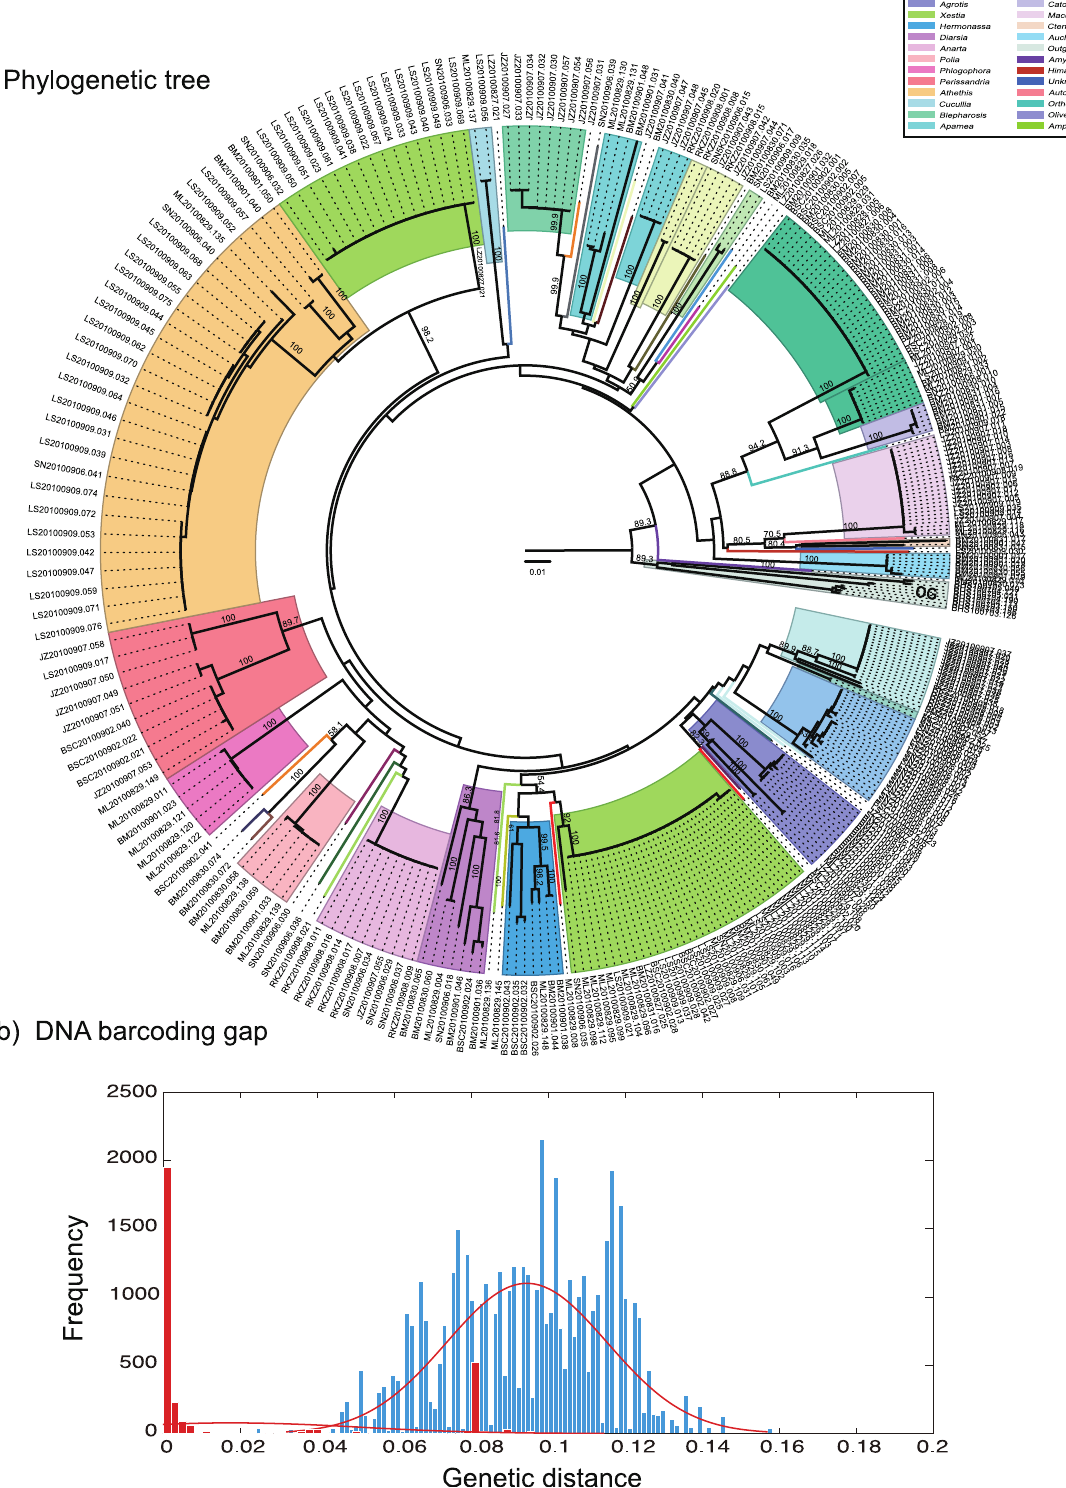
Figure 1. (a) Phylogenetic tree of Tibetan moth species from the family Noctuidae, inferred using neighbor-joining analysis of 320 COI DNA sequences. Different colours represent different genera. (b) Plot of genetic distances showing the barcoding gap. Intraspecies in red, interspecies in blue. Fitted normal distribution curves are shown in red.